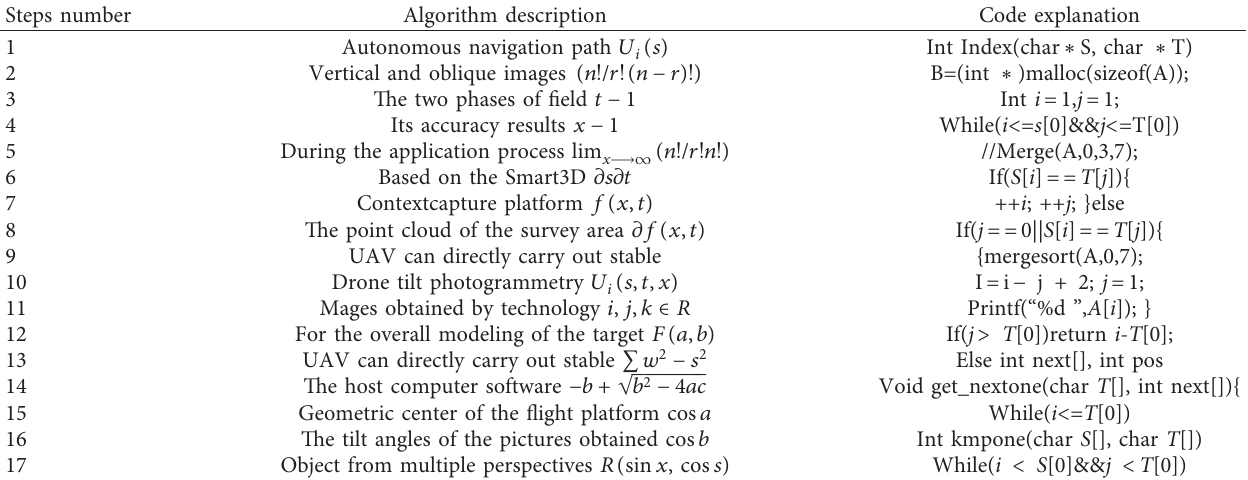
Table 3: Photogrammetric control algorithm of flight platform.